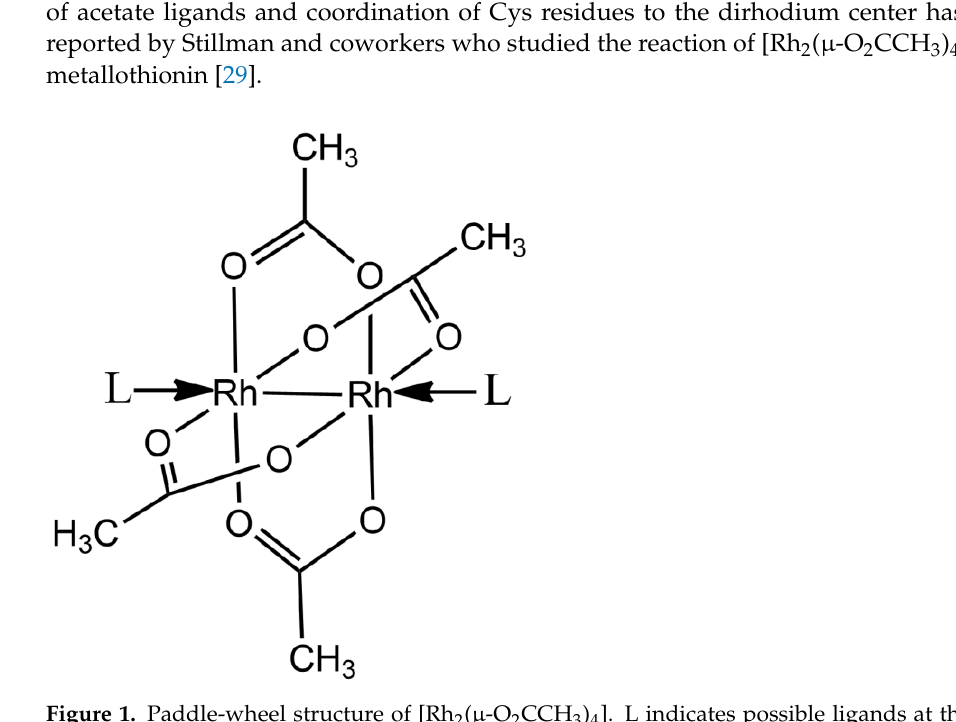
Figure 1. Paddle-wheel structure of [Rh 2 ( µ -O 2 CCH 3 ) 4 ]. L indicates possible ligands at the axial position.